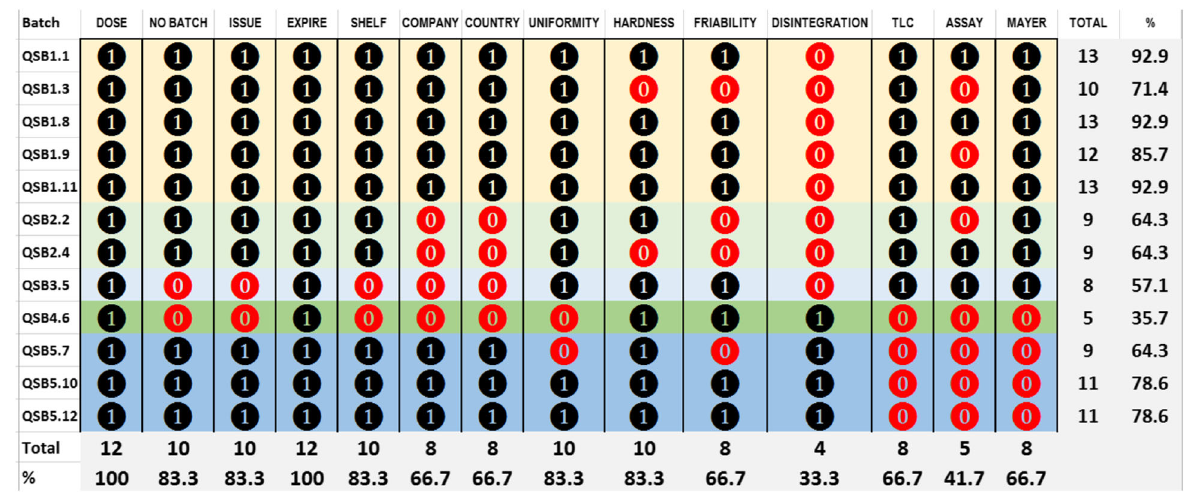
Fig. 2 Quality compliance scores of quinine batches analyzed. Dose (the content strength), no batch (batch number), issue (the issued date), expire (the expiring date), shelf (the shelf life), company (the manufacturer), country (the country of production), uniformity (the uniformity of mass), hardness (the resistance), friability (friction), disintegration (disintegration time), TLC (chromatogram), assay (dosage), and